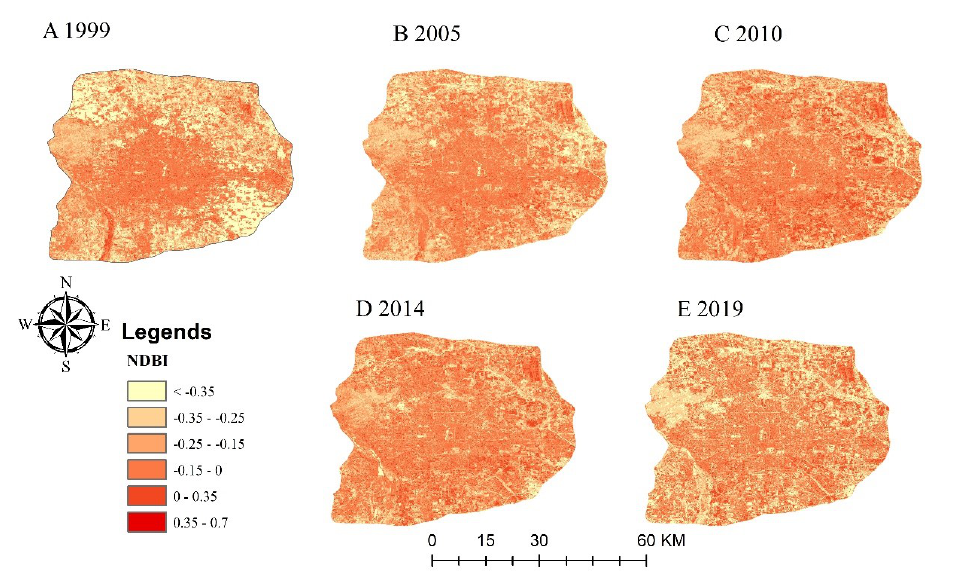
Fig. 5 NDBI in Beijing from 1999 to 2019. NDBI, normalised difference building